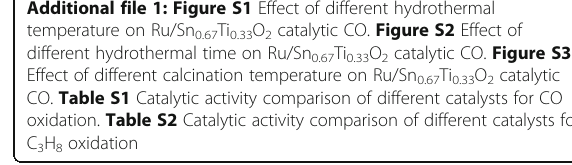
CO. Table S1 Catalytic activity comparison of different catalysts for CO oxidation. Table S2 Catalytic activity comparison of different catalysts for